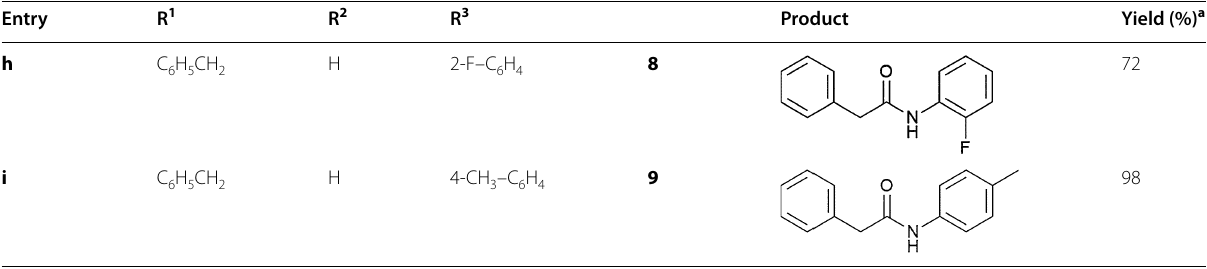
a Isolated yields